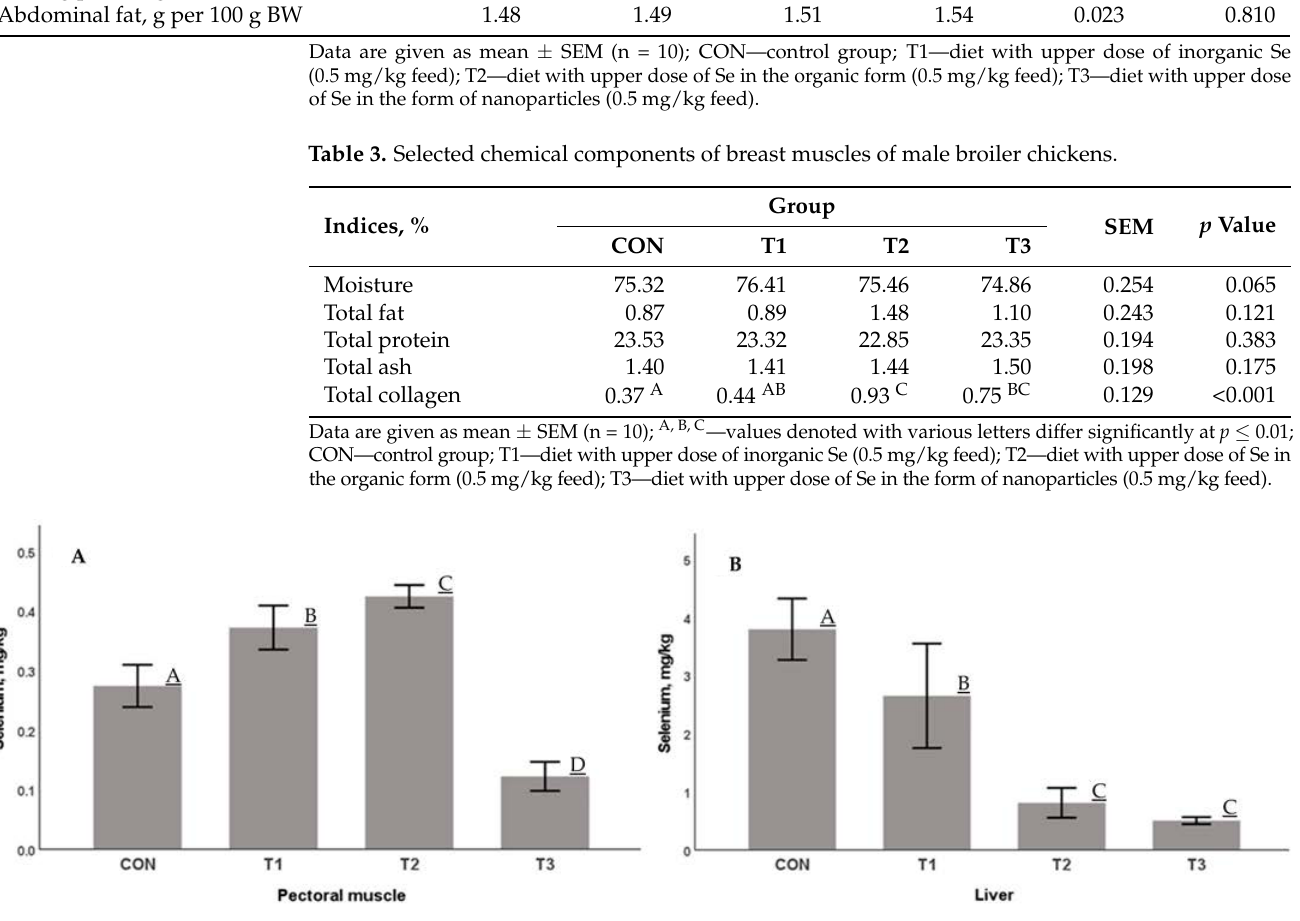
Figure 1. The effect of using increased doses of various forms of Se on Se content in tissues: ( A ) breast muscle; ( B ) liver. Data are given as mean ± SEM (n = 10). A, B, C —values denoted with various letters differ significantly at p ≤ 0.01; CON —control group; T1—diet with upper dose of inorganic Se (0.5 mg/kg feed); T2—diet with upper dose of Se in the organic form (0.5 mg/kg feed); T3—diet with upper dose of Se in the form of nanoparticles (0.5 mg/kg feed).